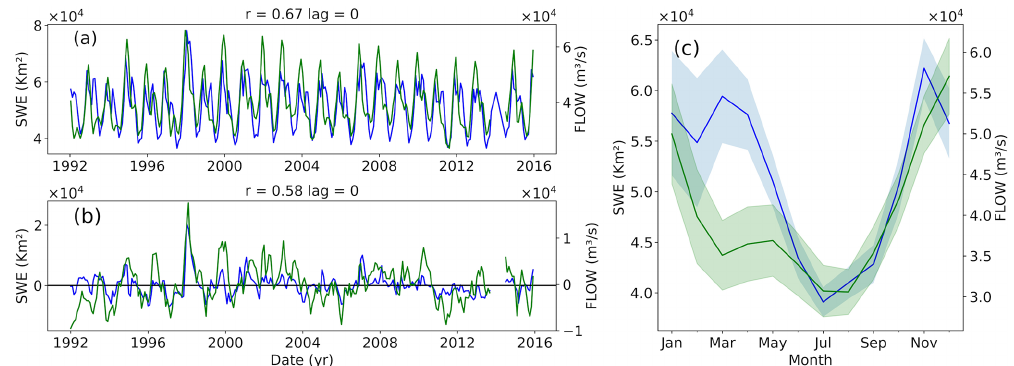
Figure 7. Comparison of monthly SWE (a) and its anomalies (b) at CRB scale against the in situ monthly mean water discharge at the Brazzaville/Kinshasa station. The blue line is the SWE, and the green line is the mean water discharge. (c) The annual cycle for both variables (1992–2015), with the shaded areas illustrating the standard deviations around the SWE and discharge